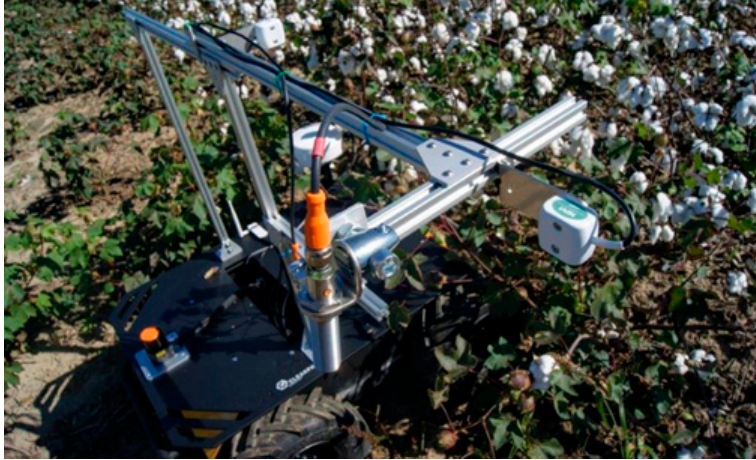
Figure 11. Cotton robot testing at Clemson University (source: agweb.com).